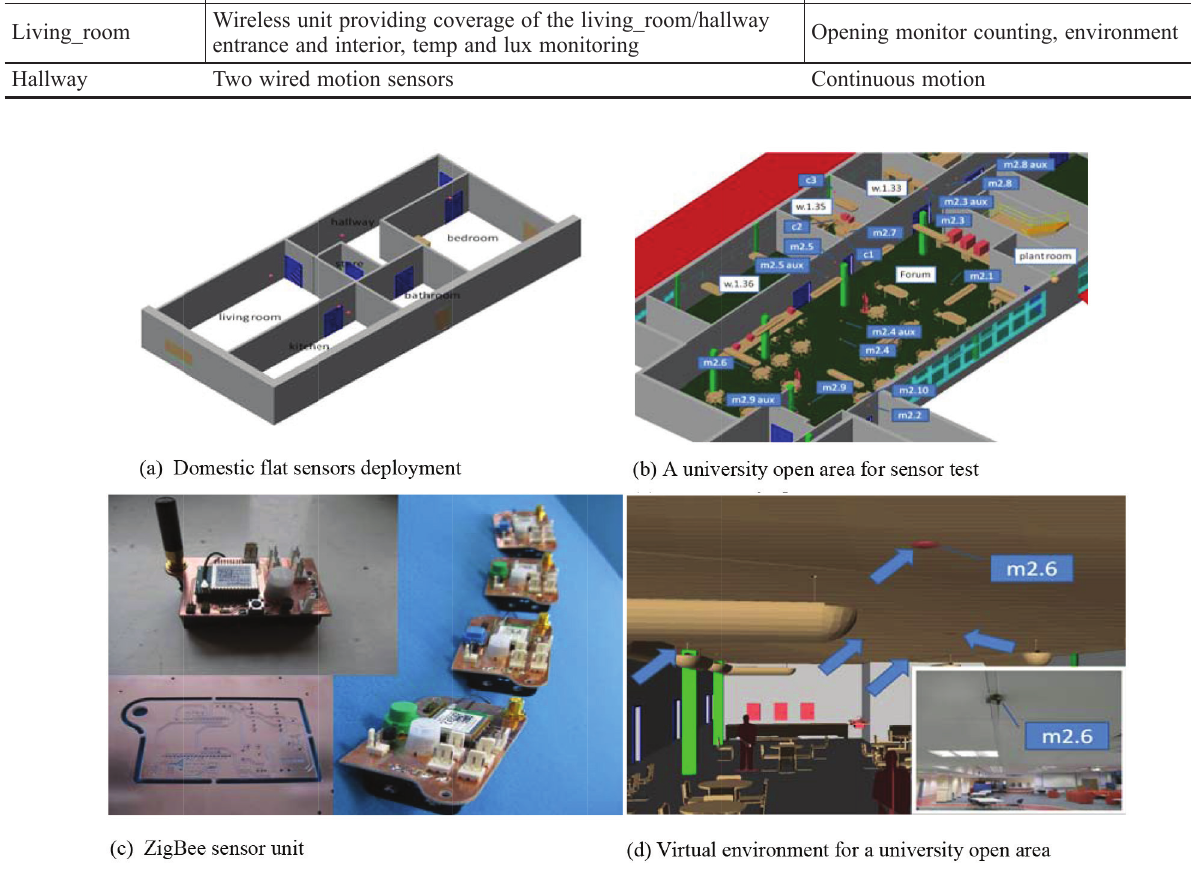
Fig. 3. ZigBee sensor units and network